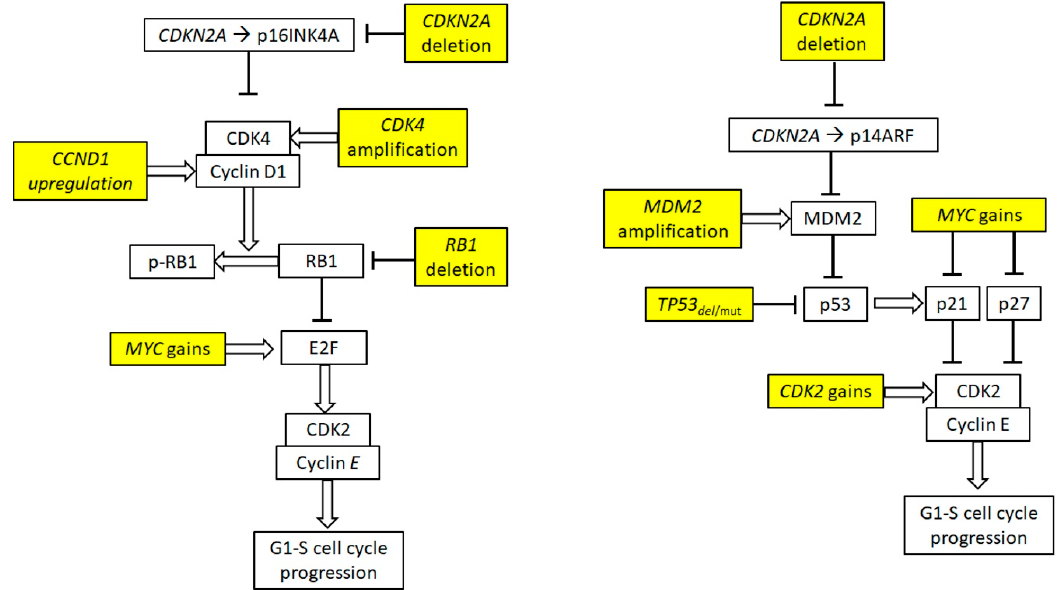
Figure 2. Cell cycle deregulation in MCL. MYC, MDM2, RB1, CCND1,